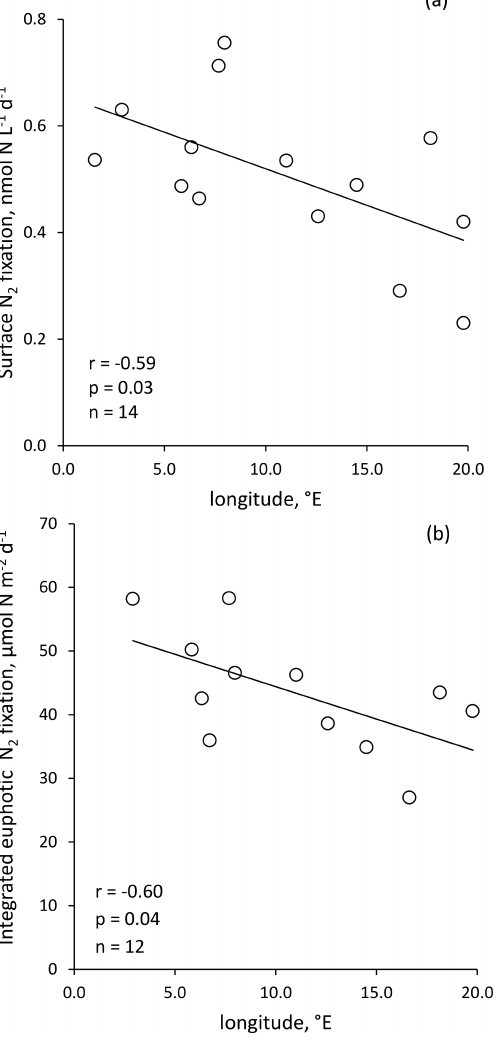
Figure 3. Volumetric surface ( ∼ 5m) (a) and integrated N 2 fixa- tion from surface to euphotic layer depth (b) along the longitudinal PEACETIME transect (Station 10 was excluded). Integrated N 2 fix- ation rate from Station 10 was excluded from statistical analysis.